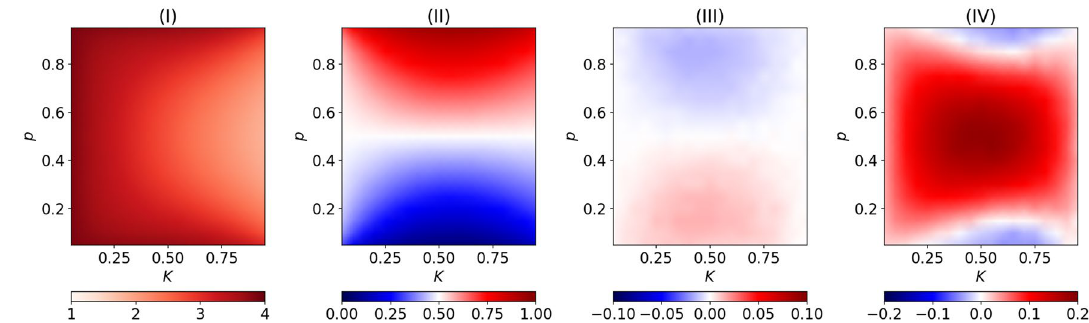
Figure 5. Simulations of the double repeated prisoner dilemma: (I) Average reward with A = 0 ; (II) Rate of intuitive play of action F when A = 0 ; (III) Variation in the rate of intuitive play of action F passing from A = 0 to A = 1 ; (IV) Variation in the average reward passing from A = 0 to A = 1